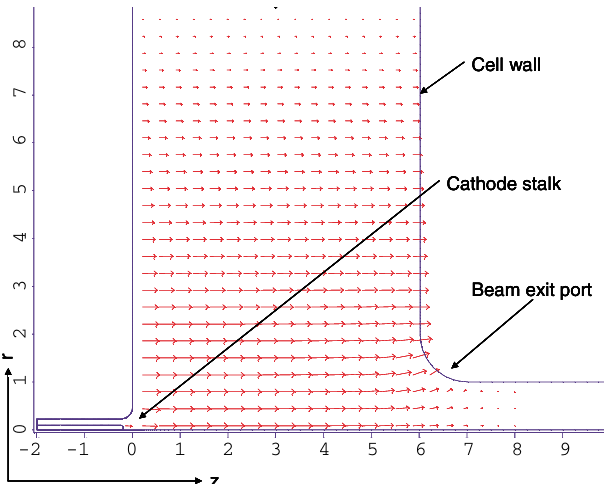
FIG. 8. (Color) FE cathode gun cell geometry. The fundamental cavity field is shown; dimensions are in centimeters.